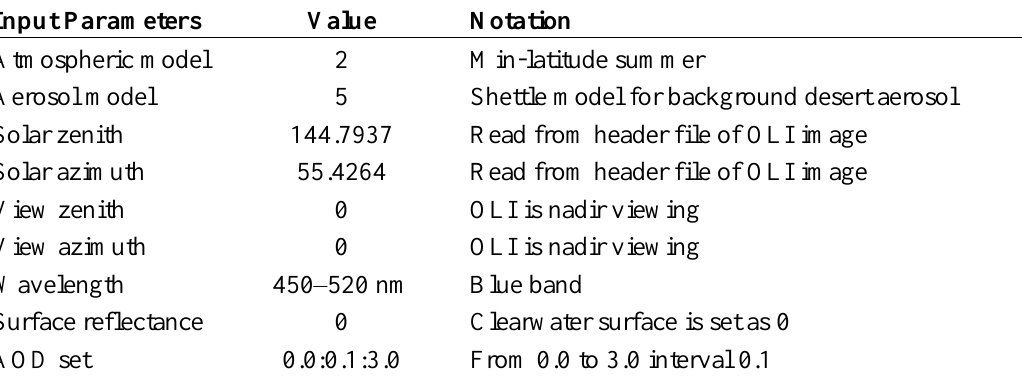
Table 5. Parameter setup for the image on 16 April 2013.